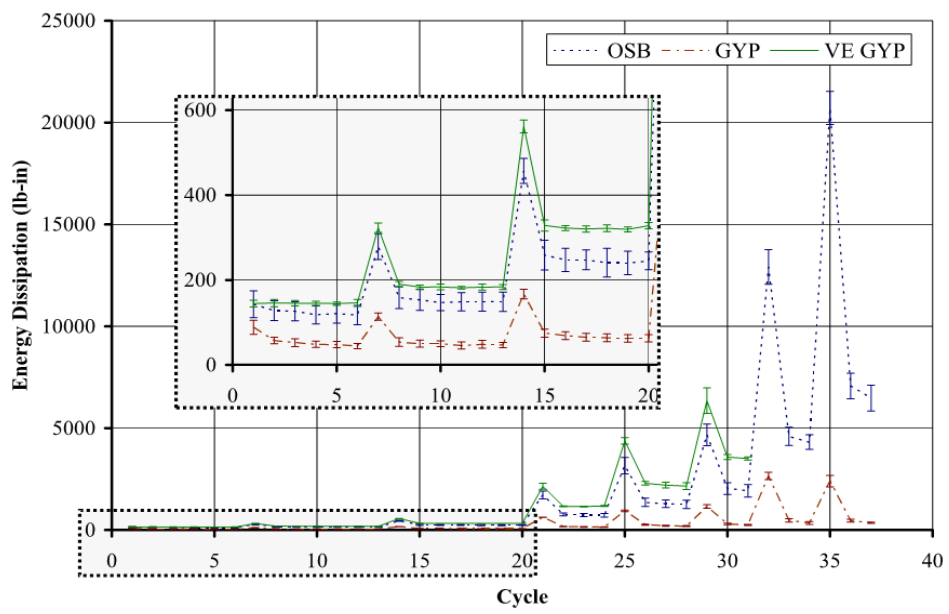
to Figure 9, trend lines, representing the average, are plotted for each wall specimen and error bars are plotted along the trend lines to illustrate the standard deviation within the data at each cycle. Figure 9. Average energy dissipation vs. cycle number for all walls.